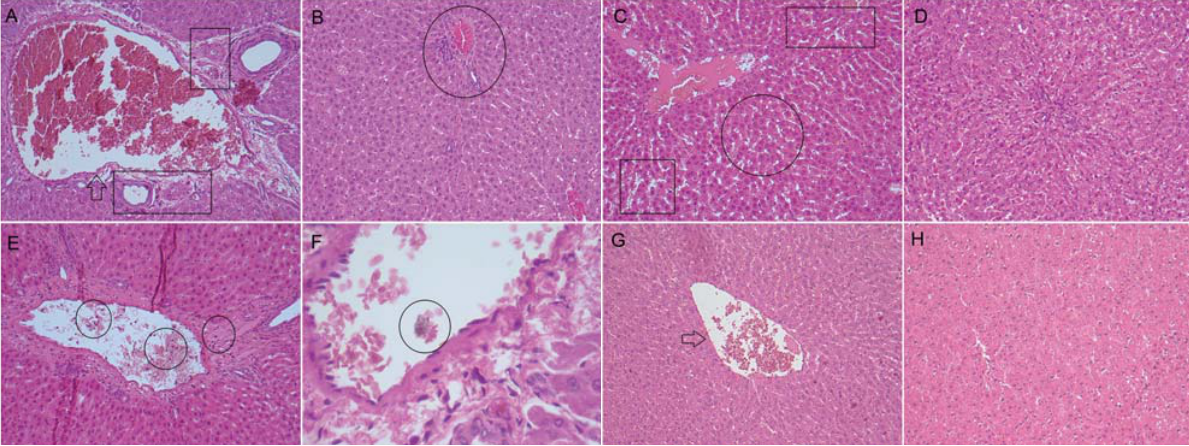
Figure 3- Photomicrographs of histological sections (5 μ m) of liver stained with hematoxylin and eosin. (A) EBBO 7 d: Details of tributary vessel of distorted, dilated and congested hepatic portal system with ruptured endothelial layer (arrow). The stroma presents